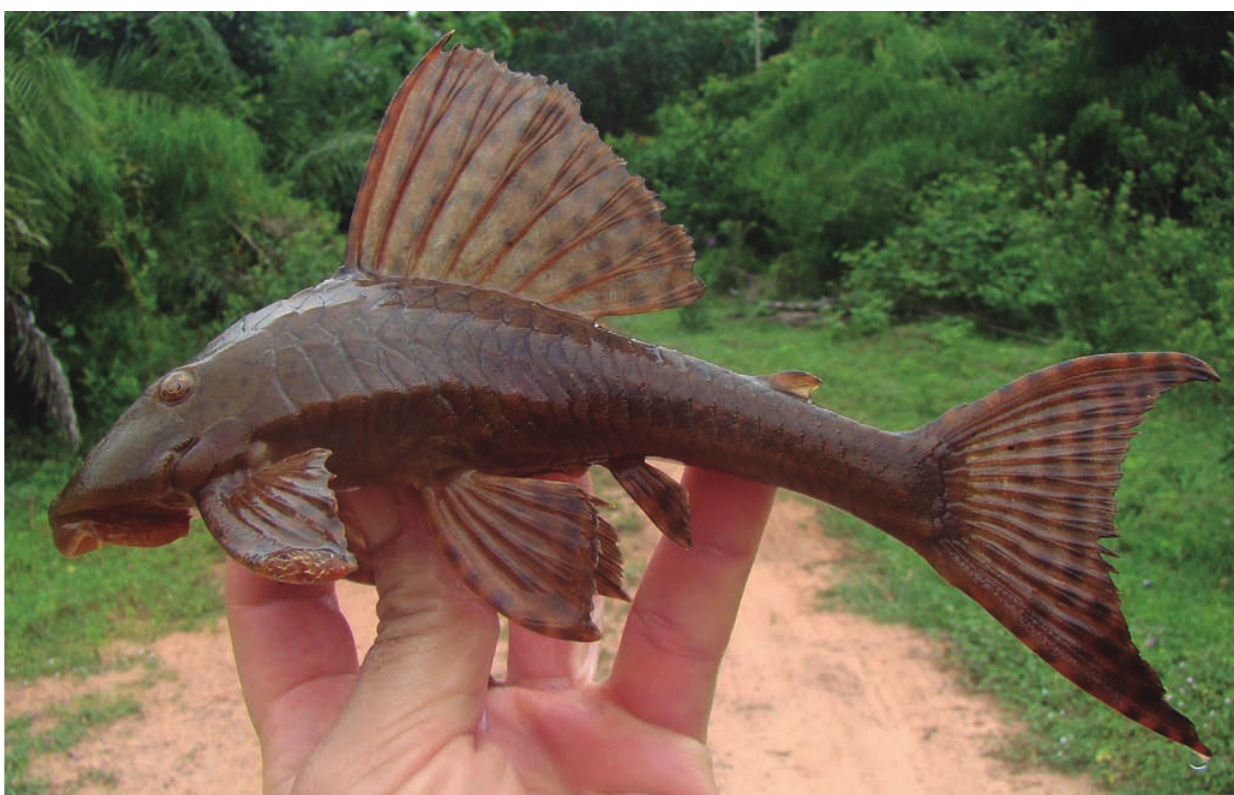
Fig. 8. Color pattern of live specimen of Hypostomus cochliodon (uncatalogued specimen) from córrego da Onça, Mato Grosso, rio Paraguay basin.